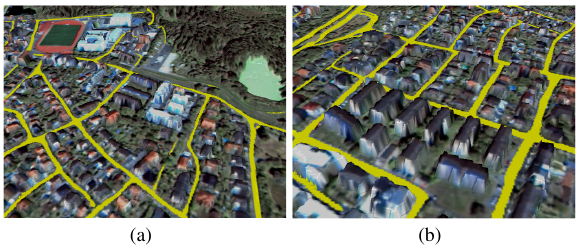
Figure 5. 3D view of the refined DSM model textured by the orthophoto and road